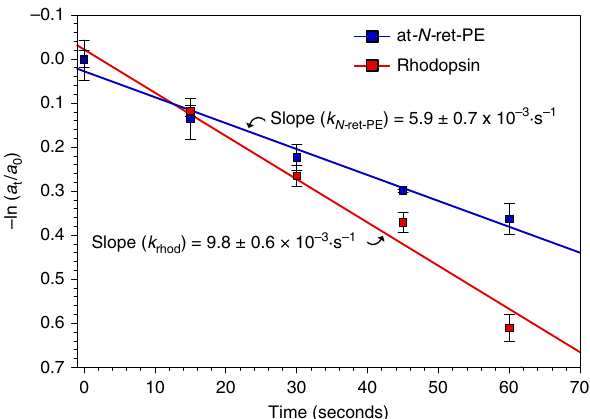
Fig. 3 Kinetics of rhodopsin and N- ret-PE photoisomerization. Protonated at- N- ret-PE and rhodopsin were exposed to 450-nm or 500-nm monochromatic light respectively at the same photon fl ux for the indicated times. The initial amounts of at- N- ret-PE and rhodopsin are represented by a t by a fi rst-order rate constant ( k ) is 0 , and the amounts at time t . The described by: kt = − In( a t / a 0 ). Here, the slopes of the plots − In( a t / a 0 ) versus t yield the rate constants k ( N- ret-PE) and k (rhod) . Each data point is shown as the mean ± s.e.m. ( n = 3). The rate constants are also shown as mean ±